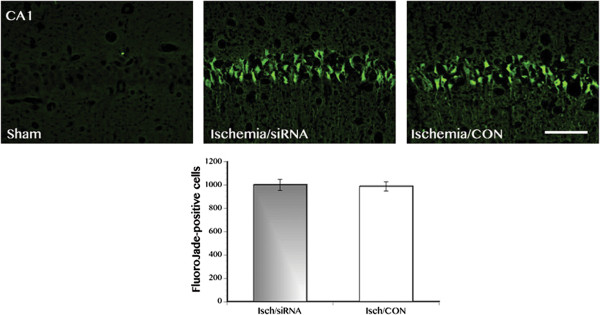
Evaluation of ischemia-induced neurodegeneration using Fluoro-Jade staining. Representative photomicrographs of FluoroJade staining are shown in the upper panel. FluoroJade staining was confined to the CA1 region of the hippocampus. Scale bar = 50 μm. No significant difference in the number of FluoroJade-positive cells between the ischemic control and ischemic CX3CR1 deficient rats.